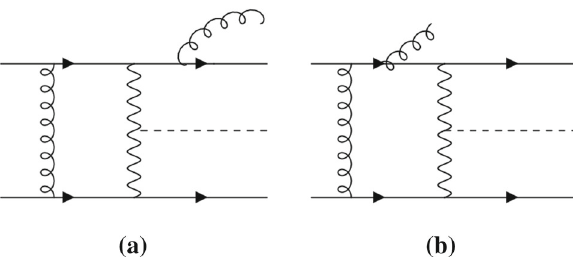
Fig. 3 Representative hexagon and pentagon one-loop Feynman dia- gram topologies for h + 3 jet